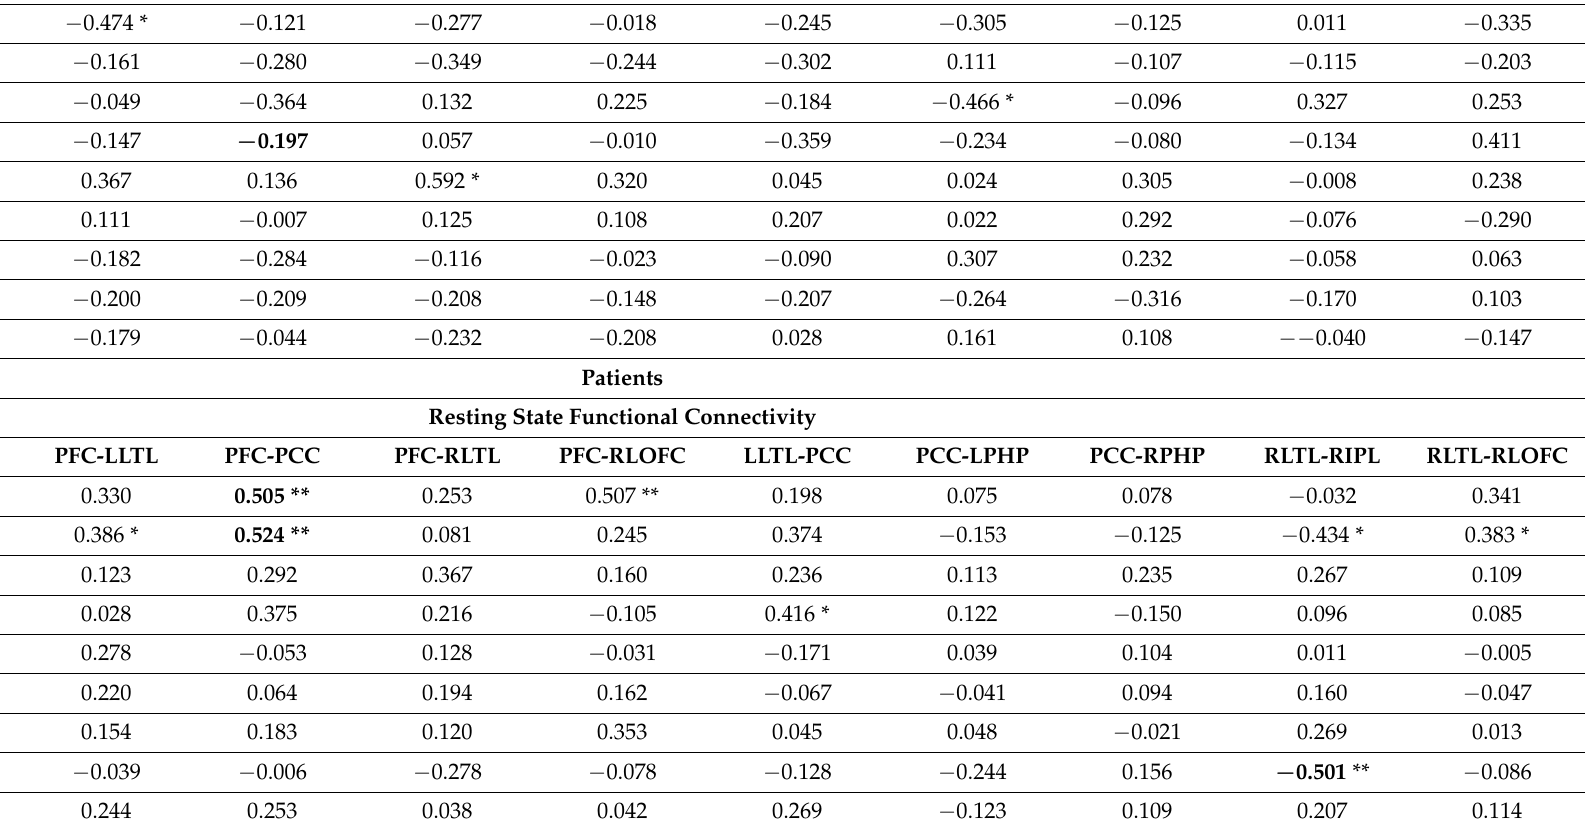
Table 3. Spearman correlations ( ρ ) between resting state functional connectivity and number of streamlines for region pairs. Controls Resting State Functional